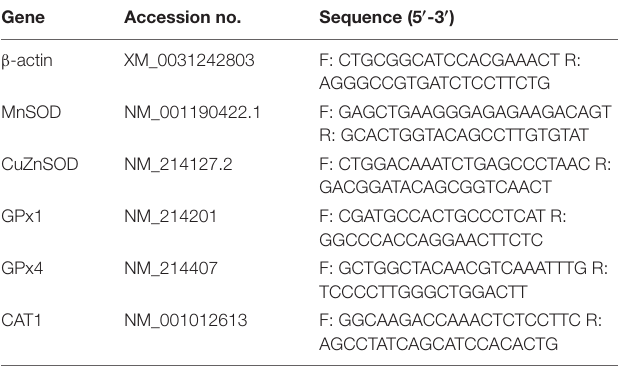
TABLE 2 | Primers used for quantitative reverse transcription PCR.